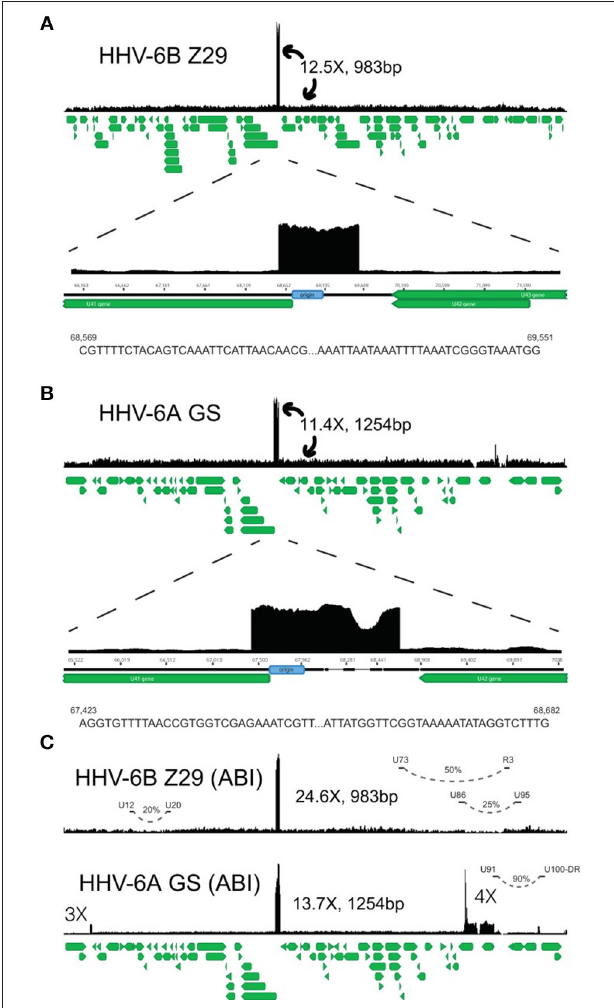
FIGURE 2 | HHV-6A and HHV-6B genomic map. Representative coverage maps of HHV-6B Z29 and HHV-6A GS reference strains. Shotgun DNAsequencing reads from cultured virus were mapped to the NCBI HHV-6B and HHV-6A reference genomes, NC_000898 and NC_001664, respectively. The green stacked lines indicate the gene models for the respective viral species. (A) HHV-6B strain Z29 yielded a homogeneous 983-bp tandem repeat that was present at ∼ 12.5 times higher coverage than the rest of the genome. Sequences at the 5 = and 3 = ends of the tandem repeat in strain Z29 are depicted and are different than those indicated previously (31). (B) HHV-6A strain GS yielded a heterogeneous 1,254-bp tandem repeat that was present at ∼ 11.4 times higher coverage than the rest of the genome. Sequences at the 5 = and 3 = ends of the heterogeneous tandem repeat in strain GS are depicted. (C) ABI quantitative DNA material for HHV-6A GS and HHV-6B Z29 also demonstrated similar origin tandem repeats with additional loci with copy number differences in the GS strain. Long-distance rearrangements between U12 to U20, U73 to R3, U86 to U95, and the U91-to-U100/DR intergenic region are represented by curved dashed lines, and the estimated viral subpopulation containing the respective deletion is indicated by the percentage. From Greninger et al.